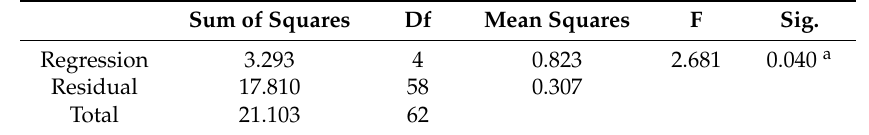
Table 10. The regression analysis of the factors on the functionality evaluation by urban designers. Sum of Squares Df Mean Squares F Sig. Regression 3.293 4 0.823 2.681 0.040 a Residual 17.810 58 0.307 Total 21.103 62